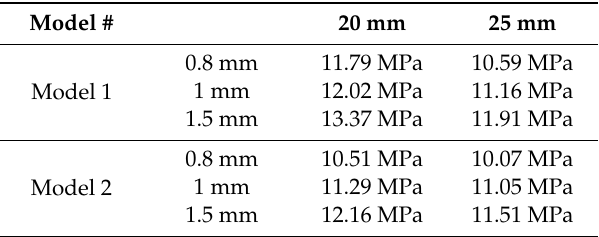
Table 3. High-stress values of the mandibular cortical bones, the cortical bone near the 3D-printed implant. Model